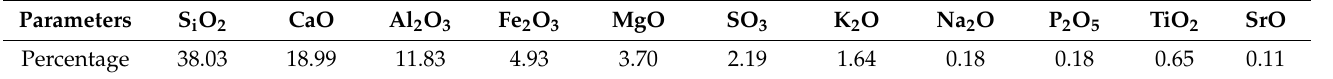
Table 3. Chemical composition ( wt %) of the DSD material.